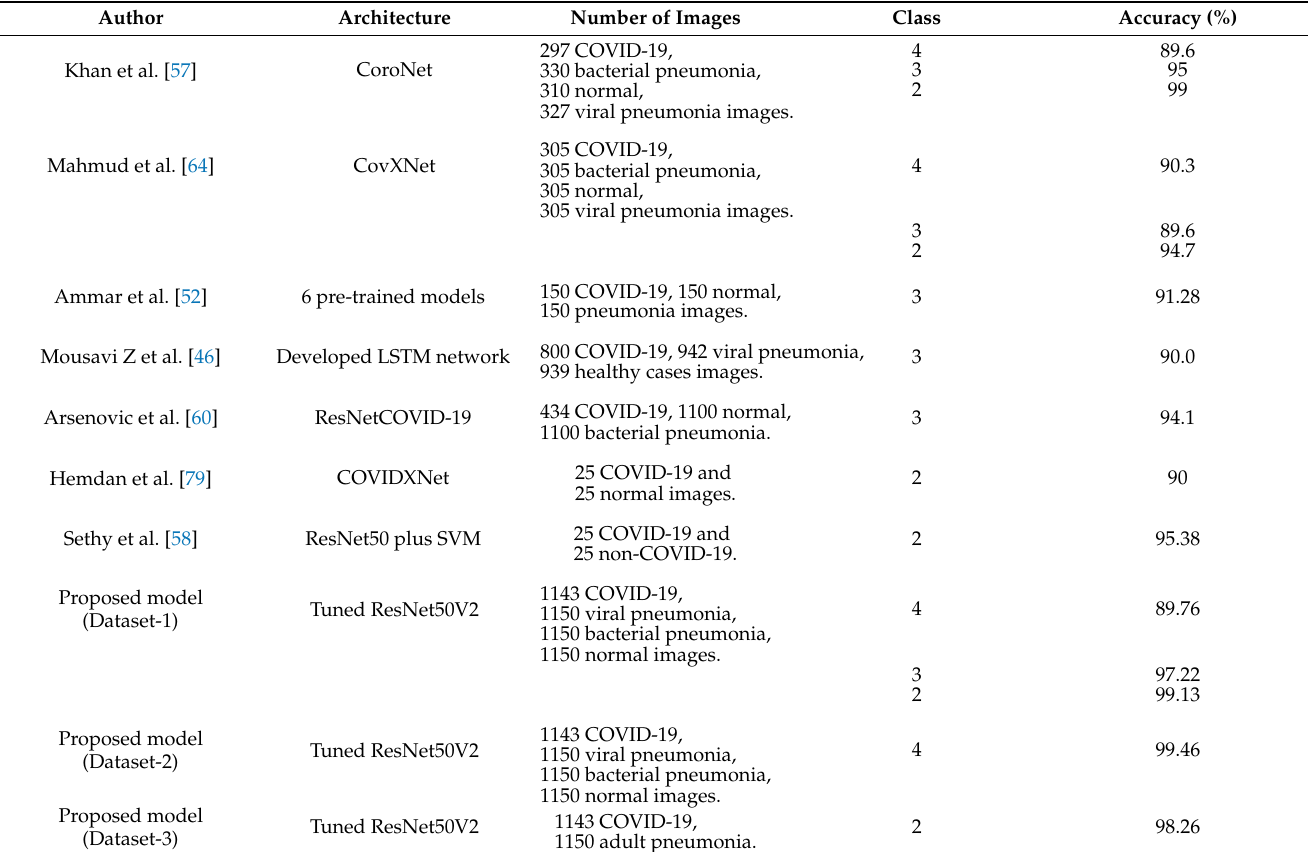
Table 12. Performance results comparison among the suggested model and the other previous state-of-the-art